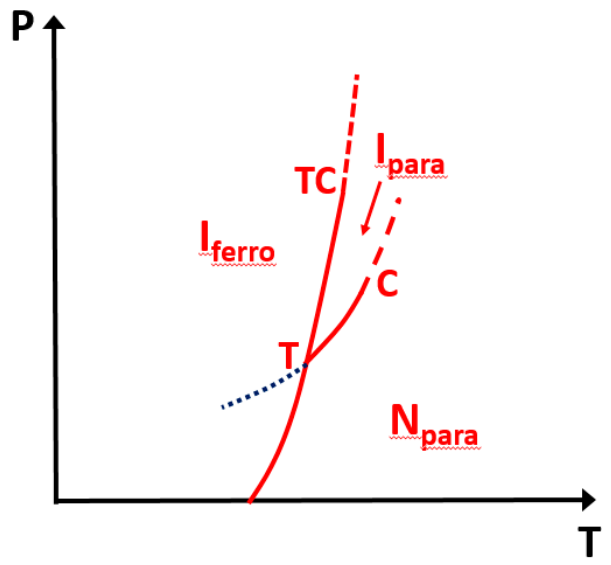
Figure 14. Schematic picture of the situation of TTF-CA through its phase diagram. Above the triple point (T), two first-order transition lines emerge: the ferro-paraelectric transition one which becomes a second-order transition line above the tricritical point (TC) and the I para -N para isostructural one which ends at the critical point C. Above C the dotted line represents the locus of q = q c in the crossover regime (supercritical). The blue dotted line represents the hypothetic continuation of the isostructural line in the ferroelectric state.